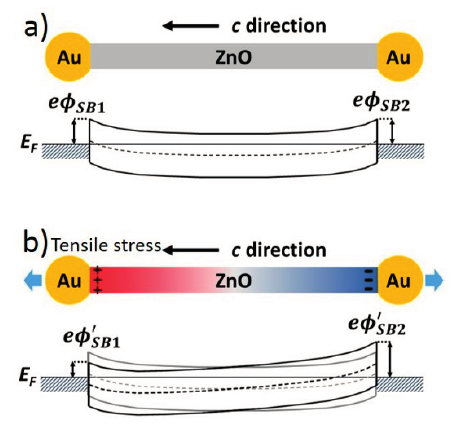
Figure 1. Schematic band diagram of a ZnO nanowire forming Schottky contact with Au electrodes. ( a ) Band diagram in the absence of strain, (cid:1857)ϕ height at the two contacts; ( b ) Band diagram in the presence of tensile strain. Positive piezoelectric charges at the left contact reduce the barrier height to (cid:1857)ϕ (cid:3020)(cid:3003)(cid:2869)(cid:4593) , and negative piezoelectric charges at the right contact increase the barrier height to (cid:1857)ϕ (cid:3020)(cid:3003)(cid:2870)(cid:4593) . The gray lines represent the original band diagram without